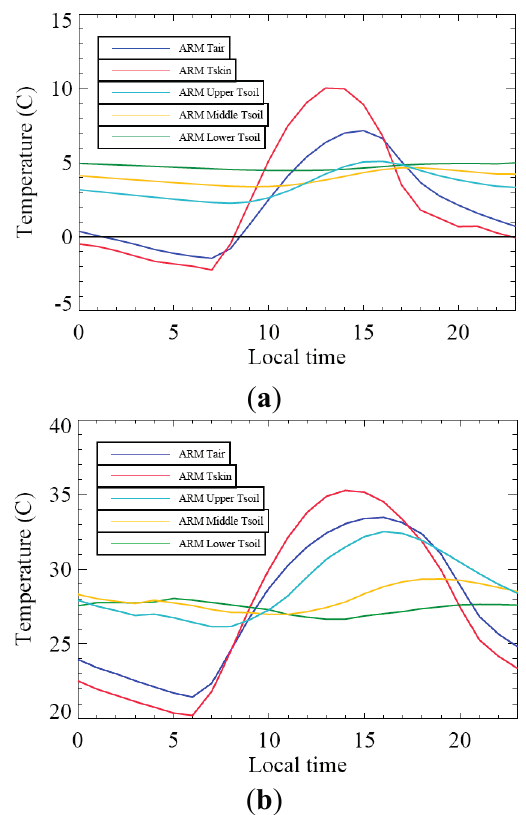
Figure 4. Multi-year (2003–2008) averaged diurnal variations of 2-m air temperature (T skin temperature (T ), and soil temperature at upper level ( − 0.05 m from ground), skin